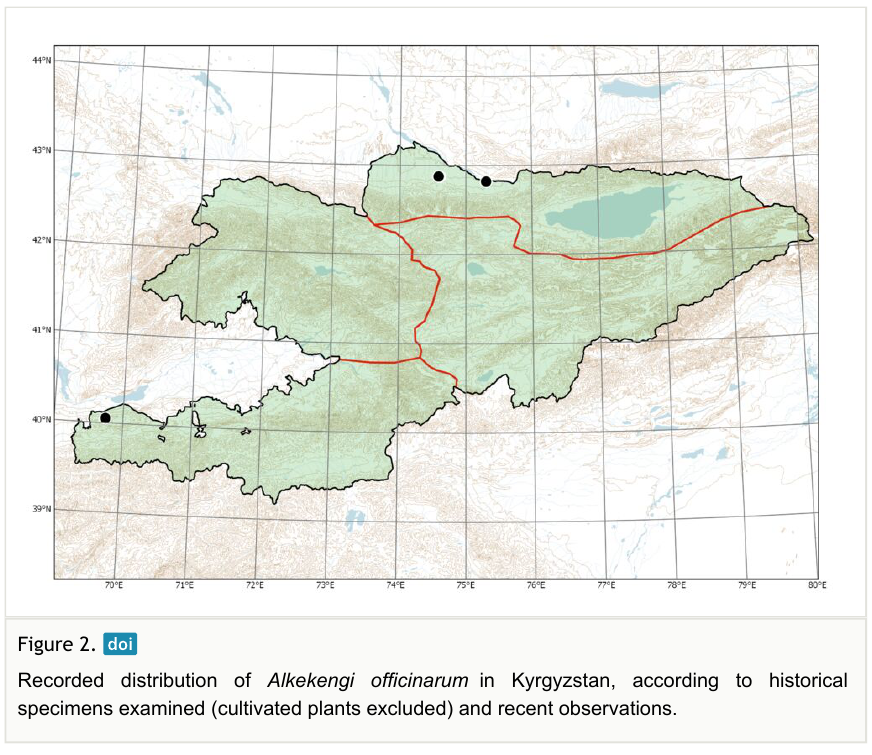
Figure 2. Recorded distribution of Alkekengi officinarum in Kyrgyzstan, according to historical specimens examined (cultivated plants excluded) and recent